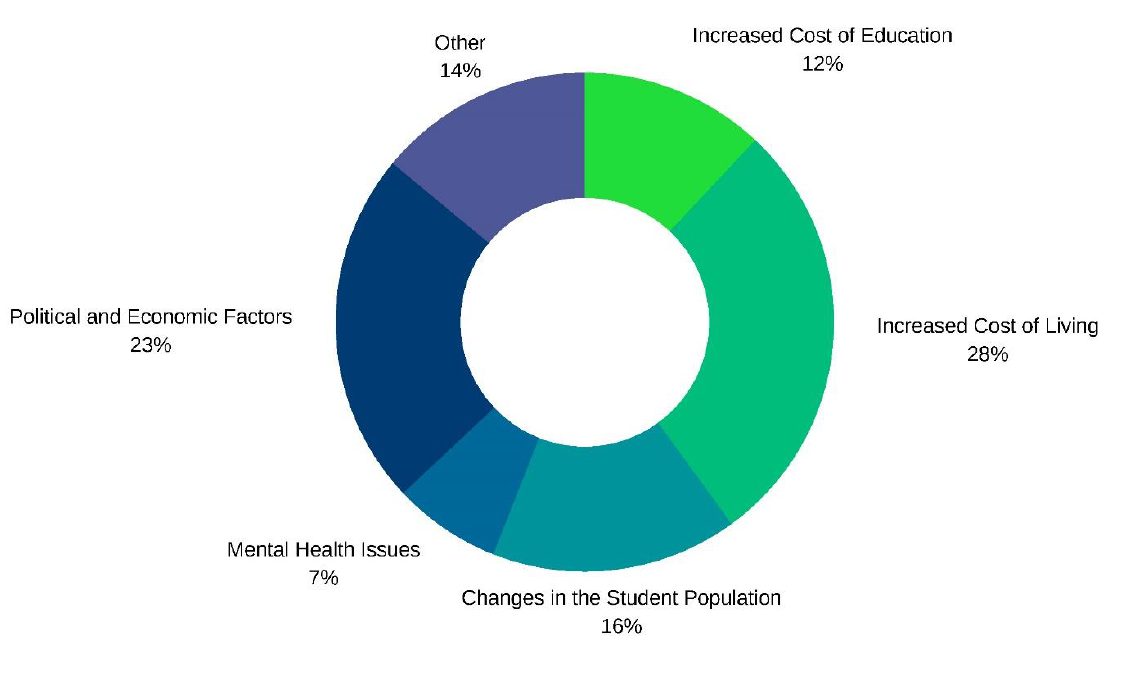
Data: Graphs Over Time activity in the faculty and staff